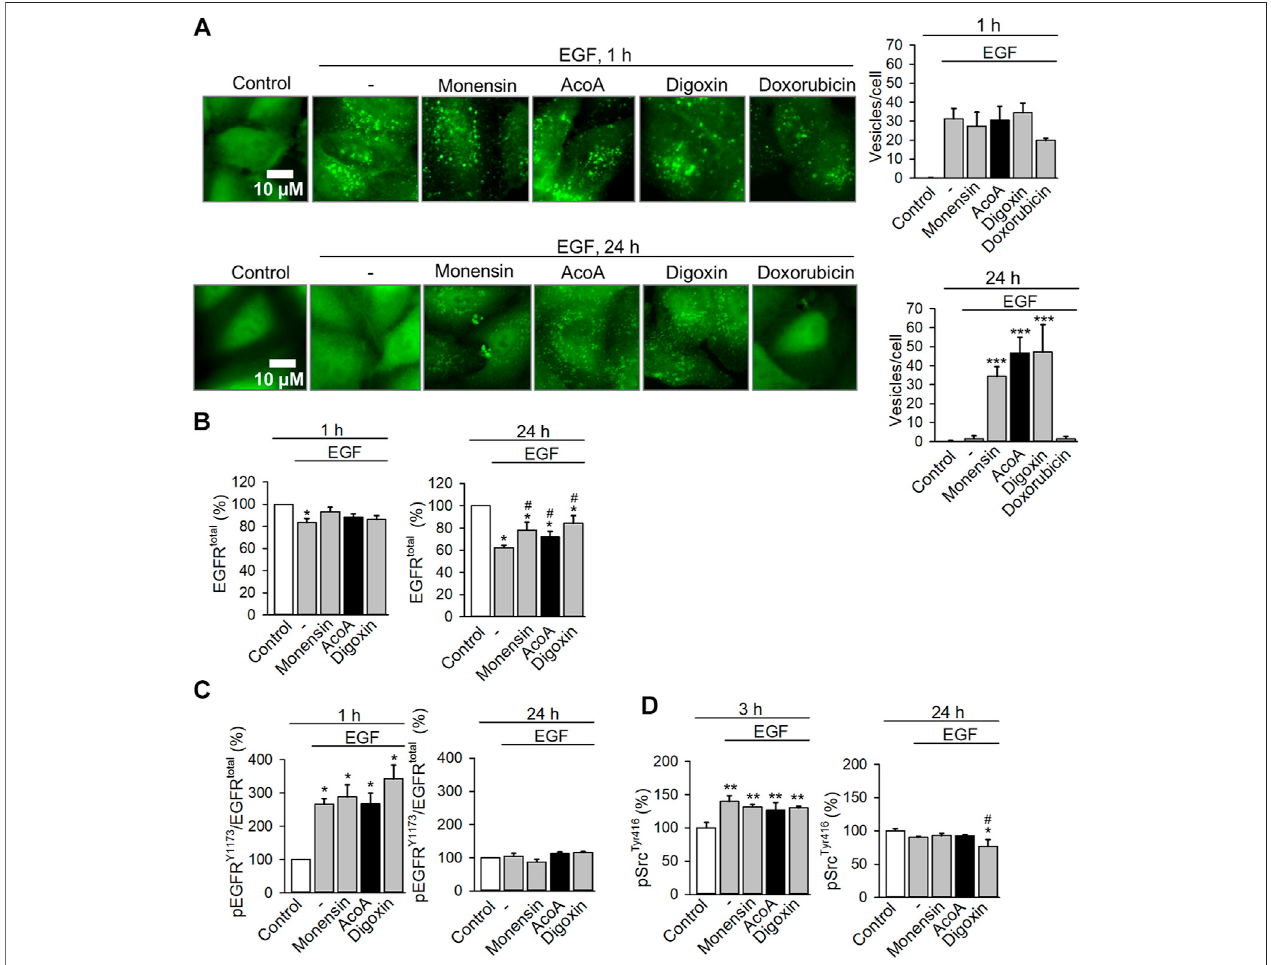
FIGURE 8 | AcoA leads to endosomal EGFR arrest and inhibits EGF-induced degradation of EGFR (A) AcoA induces endosomal arrest in EGFR biosensor cells. After 1 h preincubation with monensin (1 µM), AcoA, digoxin, doxorubicin (all 100 nM), or vehicle, cells were stimulated with 100 ng/ml EGF and the formation of green fl uorescent vesicles indicating activated and internalized EGFR was monitored microscopically. Representative images are shown. The graphs on the right show the number of fl uorescent vesicles/cellat the respective time point. Dataaremean ± SEMof N (cid:1) 3independent experiments, *** p < 0.001. (B) Quanti fi cation ofcellular EGFR in A549 cells treated as in (A) using a commercial ELISA In-cell ELISA assay. The amount of EGFR was normalized to cell number assessed by crystal violet staining.Dataaremean ± SEMof N (cid:1) 3independentexperiments,* p < 0.05vs.control,# p < 0.05vs.EGFtreatmentgroup. (C)